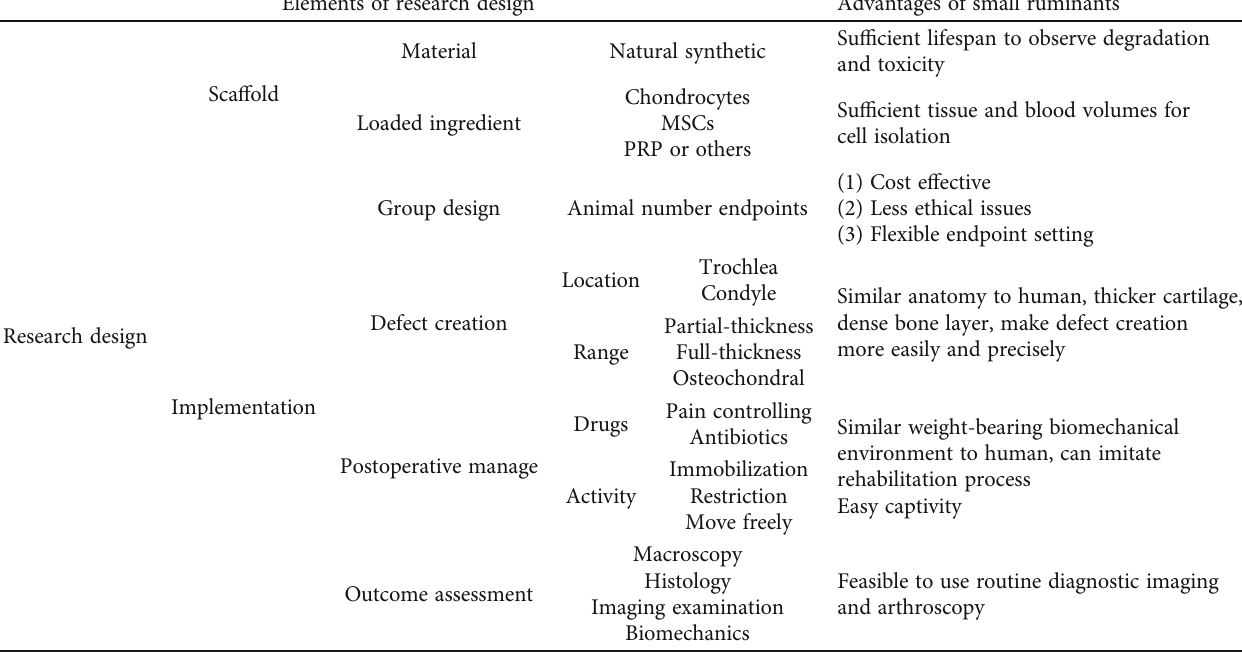
Table 2: Elements to be considered in experimental design and the advantages of small ruminants in the corresponding